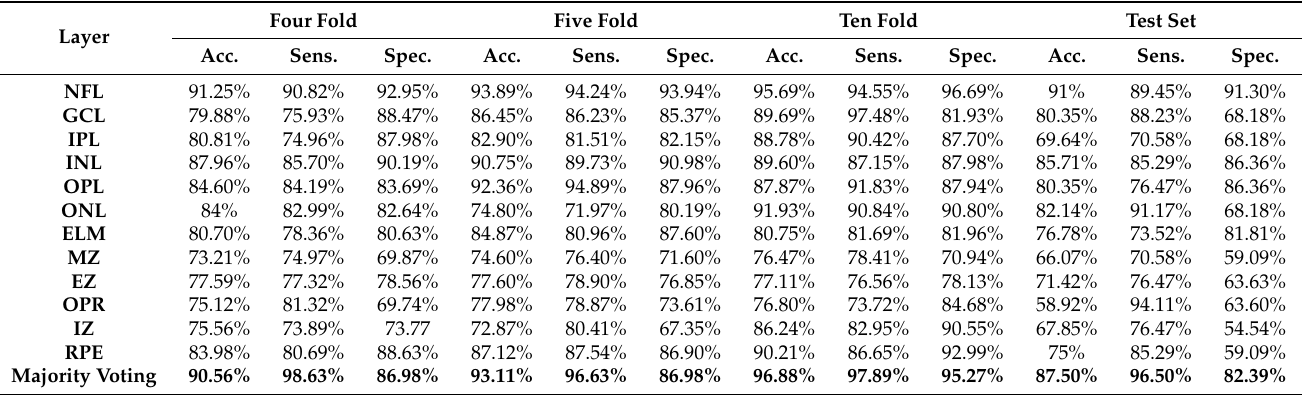
Table 1. The evaluation of the proposed CAD system for DR diagnosis. Note that Acc.: Accuracy, Sens.: Sensitivity, Spec.: Specificity.